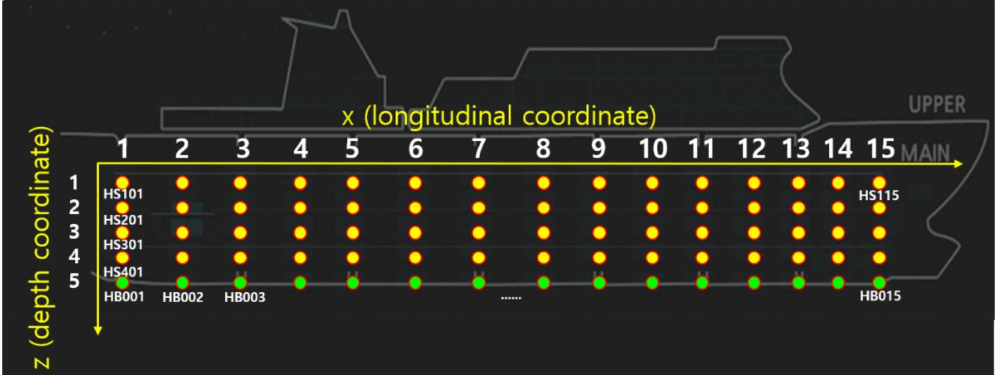
Figure 5. Identification of locations of damage centers using 3-digit codes and a coordinate system.